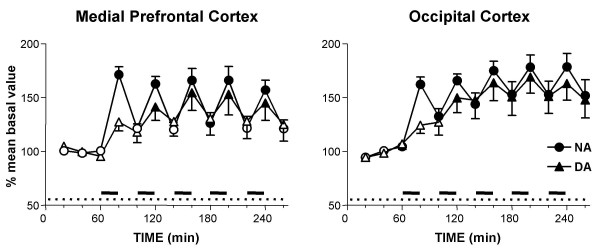
Effect of repeated locus coeruleus stimulation on extracellular NA and DA levels in the medial prefrontal and occipital cortex locally perfused with DMI. 100 μM DMI was administered through reverse dialysis for at least 2 h before stimulation, as represented by the dotted line. Stimuli were delivered in bursts, as described in Methods, for a duration 20 min (horizontal solid lines). Data are means ± SE, expressed as percent of mean basal value. Filled symbols indicate p < 0.05 with respect to basal values (Dunnett test).